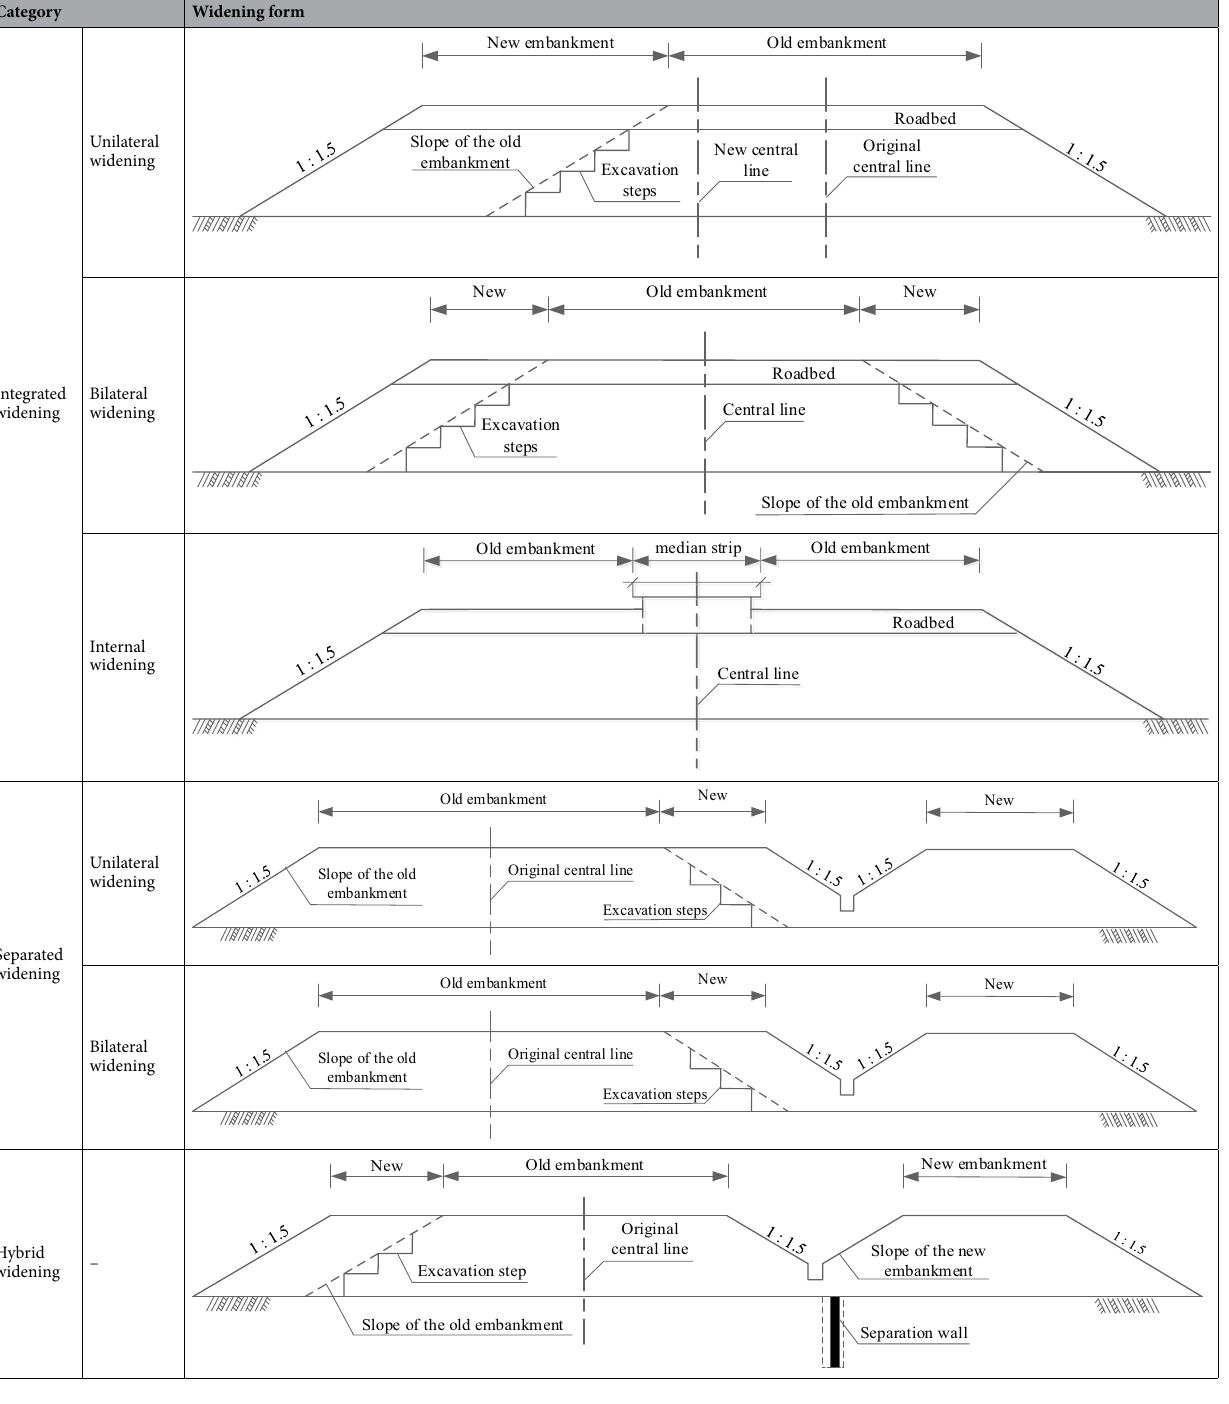
Table 1. Different types of expressway widening 10